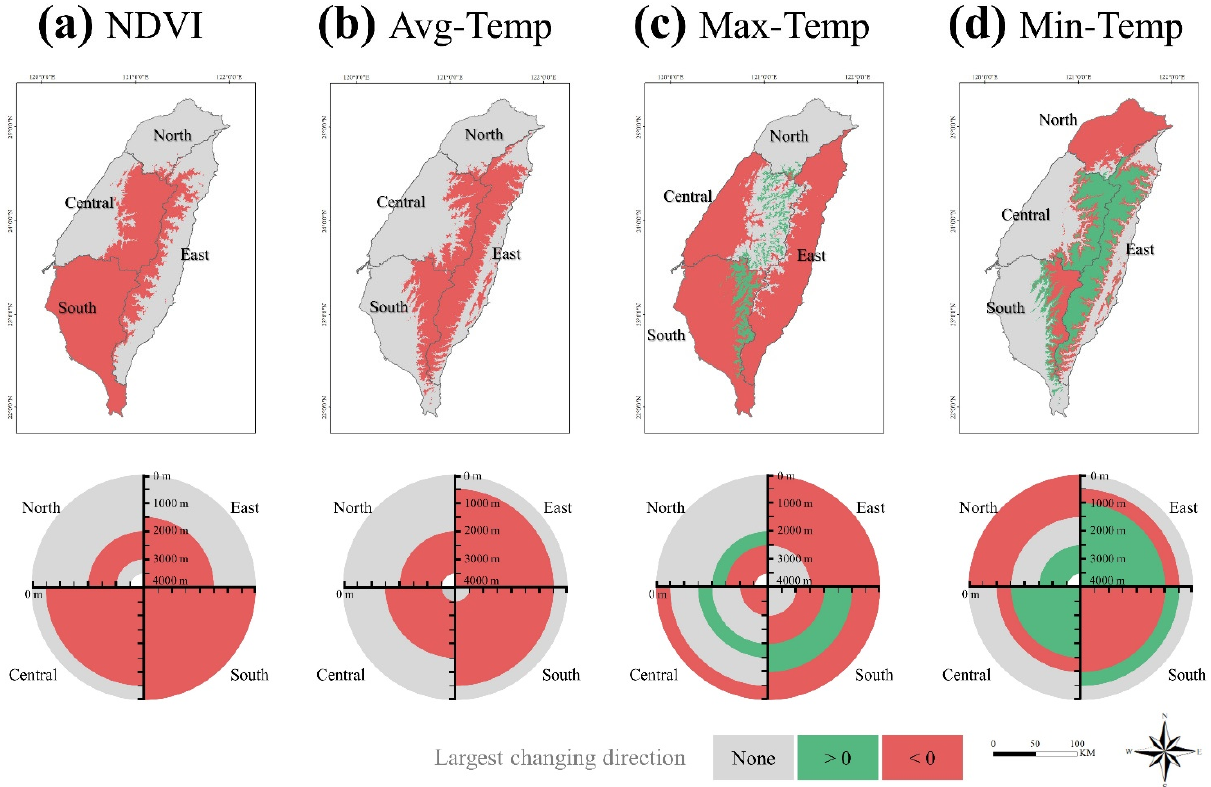
Figure 8. BFAST detected the largest change in direction for the ( a ) NDVI, ( b ) average temperature, ( c ) maximum temperature, and ( d ) minimum temperature datasets.